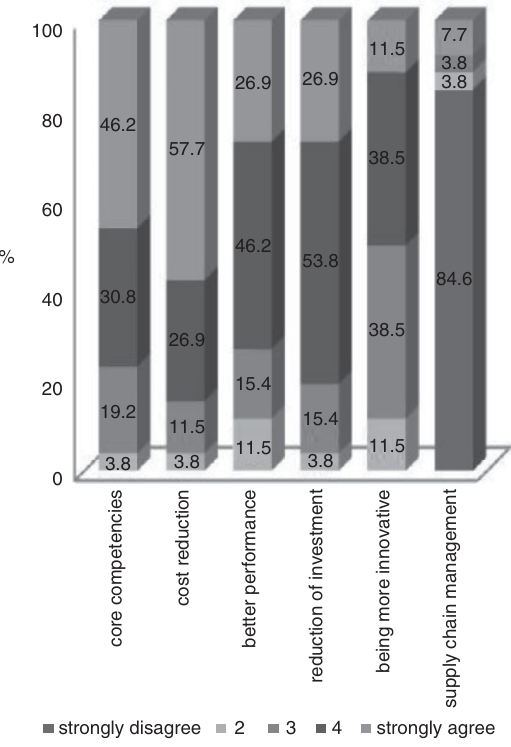
Fig. 5. Main reasons for outsourcing